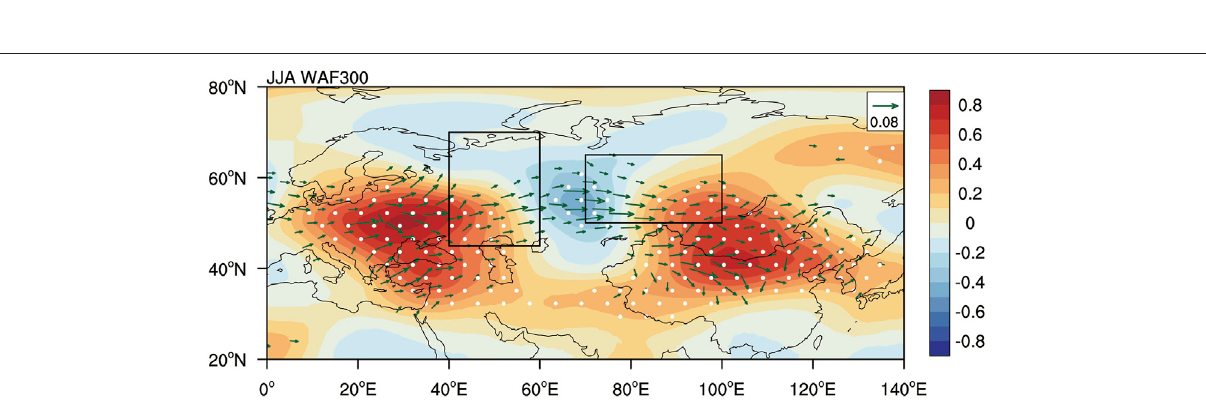
Frontiers in Earth Science |